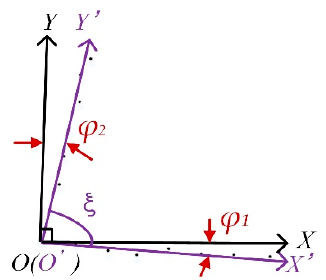
Figure 9. The identification principle of the squareness error.